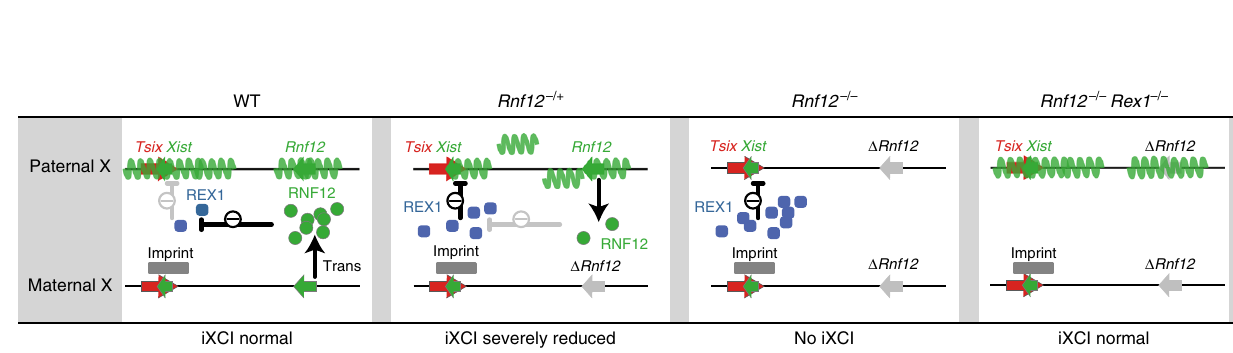
Fig. 6 Model for iXCI regulation by the Rex1-Rnf12 axis. In a WT background, REX1 is expressed during the early stages after fertilization, but is degraded by RNF12. This leads to the upregulation of the paternal Xist allele, whilst its maternal counterpart is prevented from upregulation by an imprint. In Rnf12 − / + embryos, the RNF12 level is suf fi cient to prevent REX1 stabilization, allowing for paternal Xist upregulation. However, this will result in inactivation of the paternal Rnf12 copy, which leads to an RNF12 KO situation, in its turn resulting in brief REX1 stabilization and preventing further paternal Xist upregulation. This feedback loop will prevent proper iXCI in trophoblast cells leading to Rnf12 − / + embryo death. In Rnf12 − / − embryos, in the absence of RNF12, REX1 accumulates, preventing upregulation of Xist from the paternal allele. iXCI is absent and the embryos die. In Rnf12 − / − : Rex1 − / − embryos, the entire Rex1- Rnf12 axis is absent and iXCI can proceed normally as in WT embryos